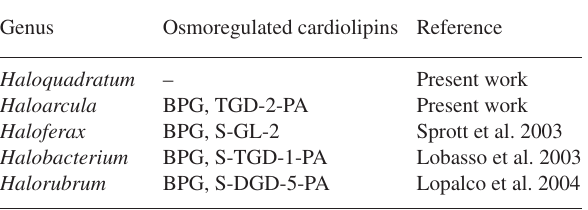
Table 2. Cardiolipins as osmo-regulated lipids in Halobacteriaceae. The Haloarcula experiments are in progress to confirm the exact structure of this novel osmo-regulated